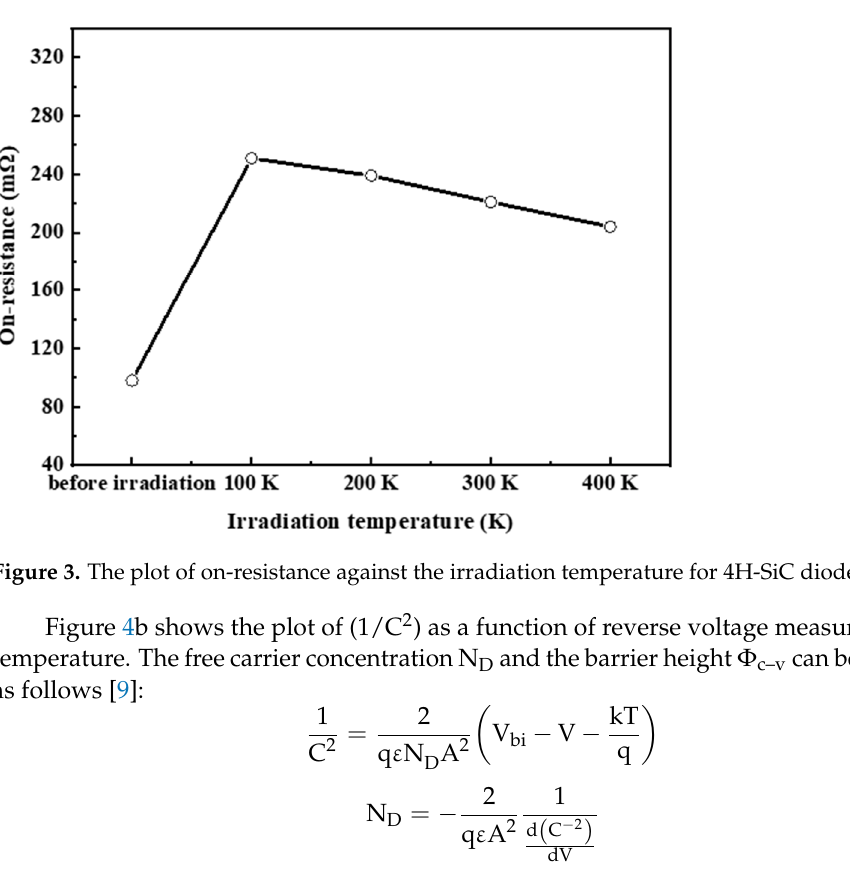
Figure 2. Forward current–voltage characteristics of 4H-SiC diodes before and after proton irradiation at different irradiation temperatures. Measurements were taken at room temperature.